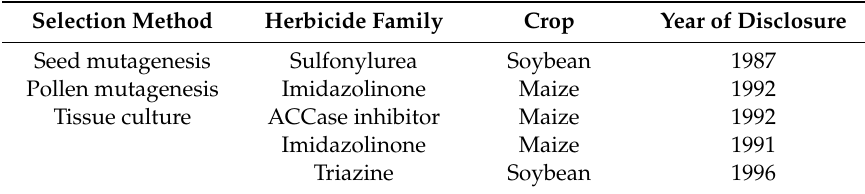
Table 1. Nontransgenic herbicide-resistant maize and soybean.